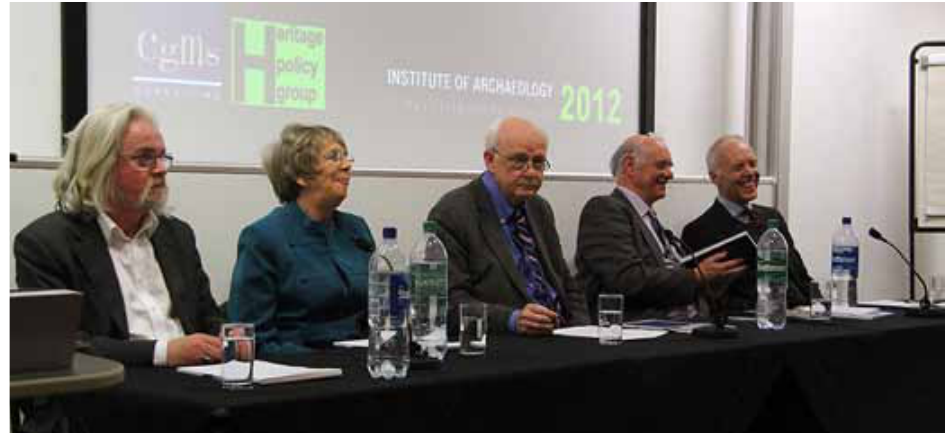
Fig. 2: The fifth ‘75th Anniversary Debate’ on the topic of ‘Archaeology into the 3rd Millen- nium’ (photo Ken